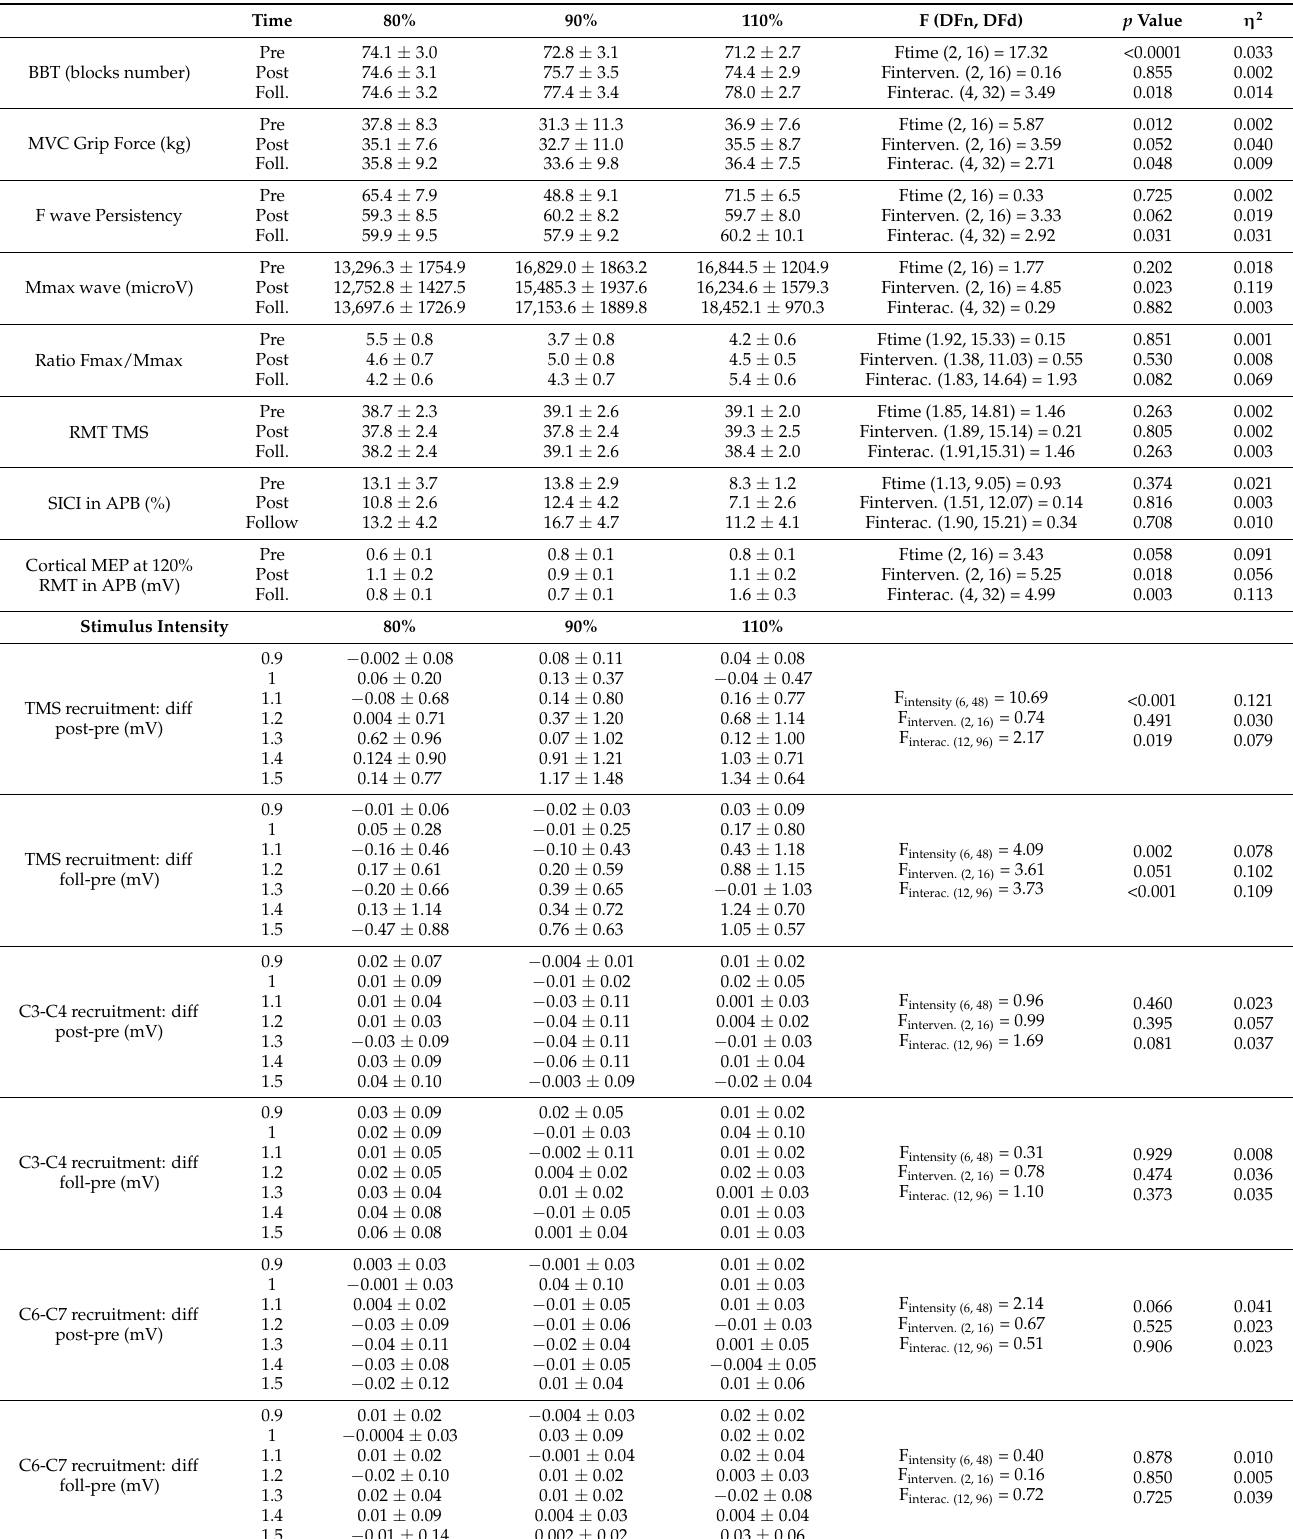
Table 2. Raw data and statistics of functional and motor strength and neurophysiological assessment during the electrical stimulus intensity for eEmc at 80%, 90% and 110% combined with maximum (100%) handgrip strength during hand